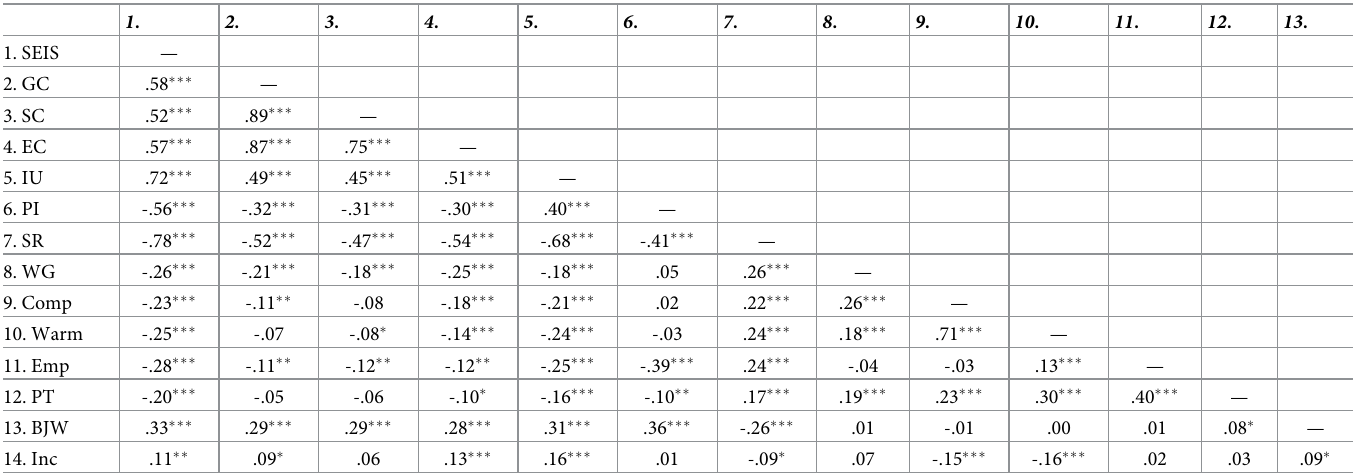
Table 3. Correlations between all scales assessing convergent validity in Study